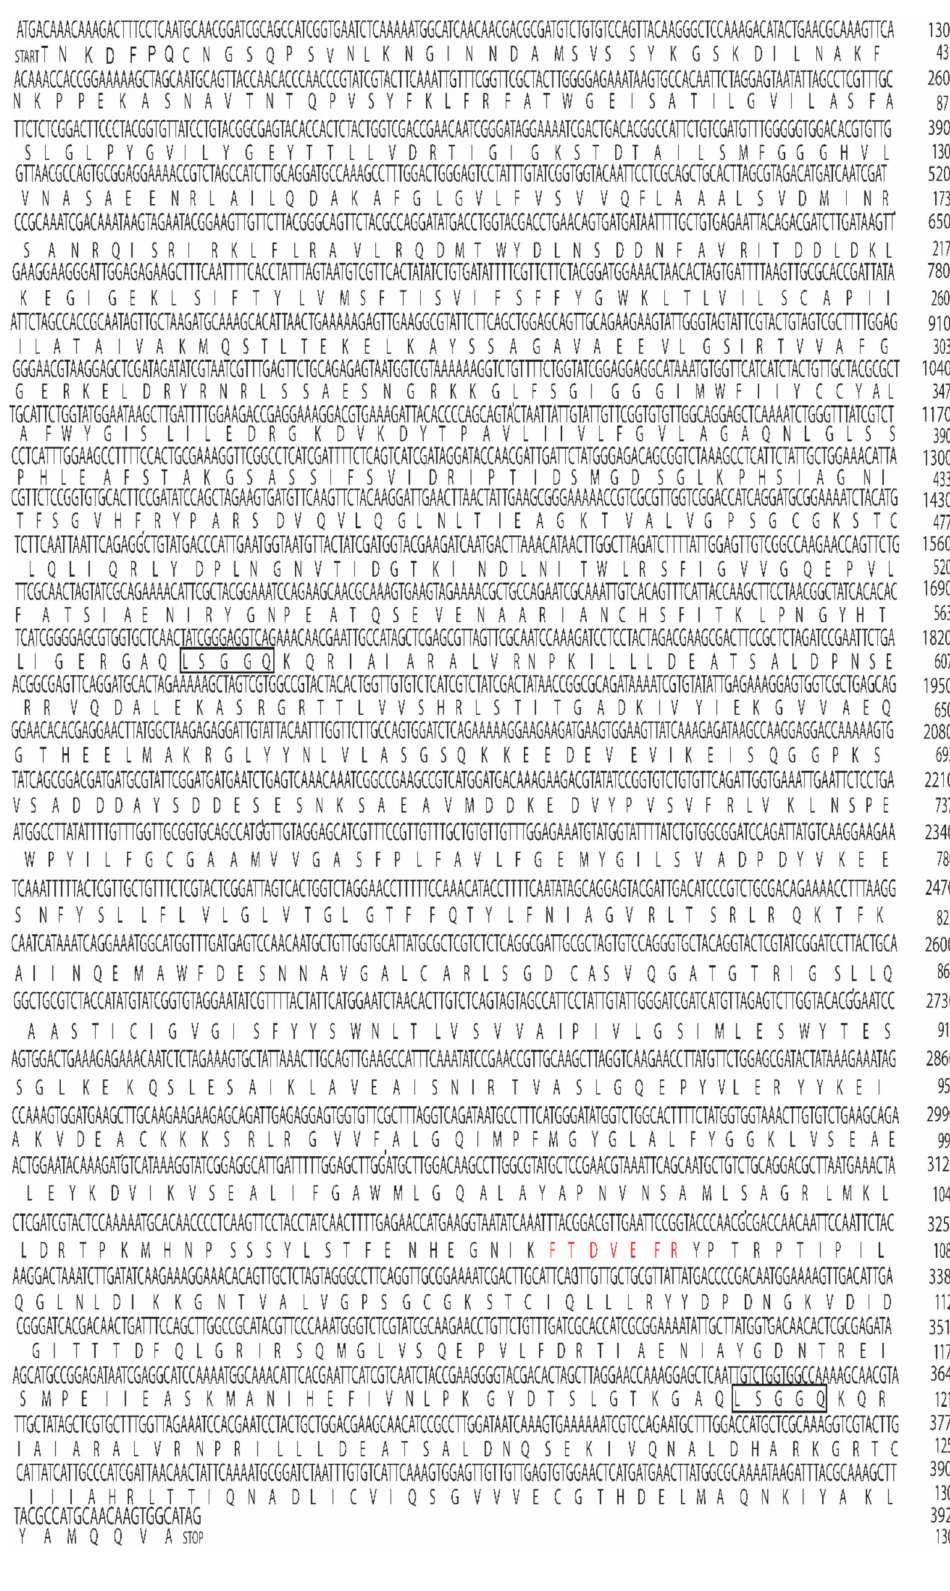
Figure 3. Aea ABC-receptor nucleotides and translated amino acids sequences. The translated protein has 1307 amino acids and two ATP signature motifs (LSGGQ) shown in black square